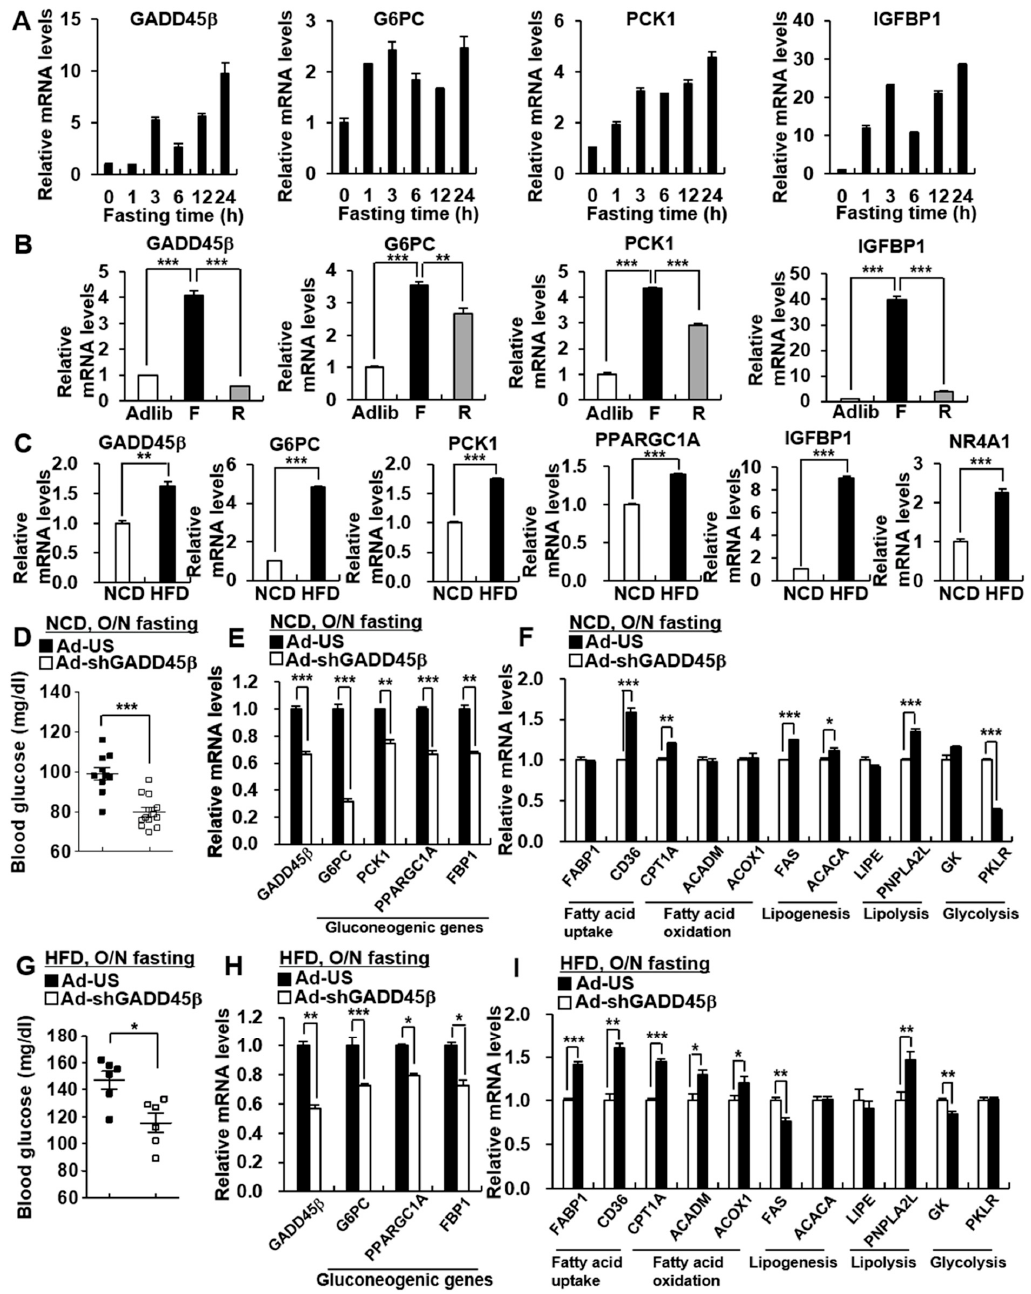
Figure 1. Knockdown of hepatic GADD45 β suppresses hepatic gluconeogenic gene expression under fasting and high-fat diet conditions. ( A ) 8-week-old male C57BL/6 mice were fasted for the indicated time ( n = 4/group). qPCR analysis showing the effects of fasting on mRNA levels of GADD45 β , G6PC, PCK1, and IGFBP1 in livers. ( B ) qPCR analysis showing mRNA levels of GADD45 β , G6PC, PCK1, and IGFBP1 in livers of 8-week-old C57BL/6 mice under ad libitum (Adlib), 24-h fasting (F), and 24-h refeeding after 24-h fasting (R) conditions ( n = 7/group). ( C ) 8-week-old male C57BL/6 mice were fed a standard chow diet (NCD) or high-fat diet (HFD) for 12 weeks ( n = 5/group). qPCR analysis showing the effects of HFD on mRNA levels of GADD45 β , G6PC, PCK1, PPARGC1A, IGFBP1, and NR4A1 in the livers. ( D – F ) 8-week-old C57BL/6 male mice were infected with Ad-shGADD45 β ( n = 15) or Ad-US control ( n = 10) for 7 days. Blood glucose levels after 16 h of fasting ( D ), qPCR analysis showing expression levels of GADD45 β , gluconeogenic genes ( E ), and other metabolic genes ( F ). ( G – I ) 8-week-old C57BL/6 male mice were fed a HFD for 12 weeks and then were infected with Ad-shGADD45 β ( n = 6) or Ad-US control ( n = 6) for 7 days. Blood glucose levels after 16 h of fasting ( G ), qPCR analysis showing expression levels of GADD45 β , gluconeogenic genes ( H ), and other metabolic genes ( I ). Data in ( A – C , E , F , H , I ) represent the mean ± SD, and data in ( D , G ) represent the mean ± SEM (* p < 0.05; ** p < 0.005; *** p < 0.0005; t